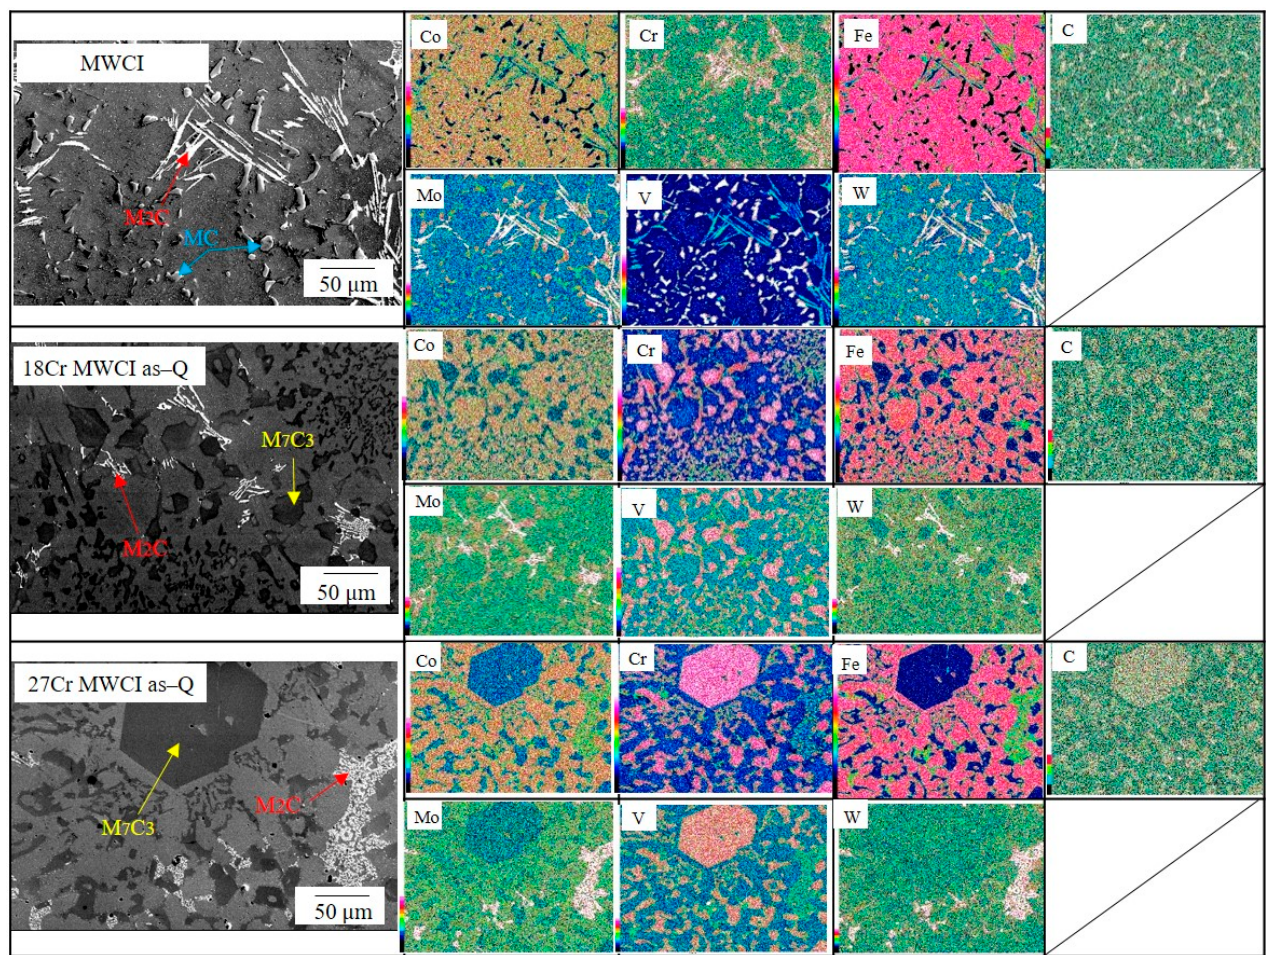
Figure 5. SEM and EDS mapping of representative materials.